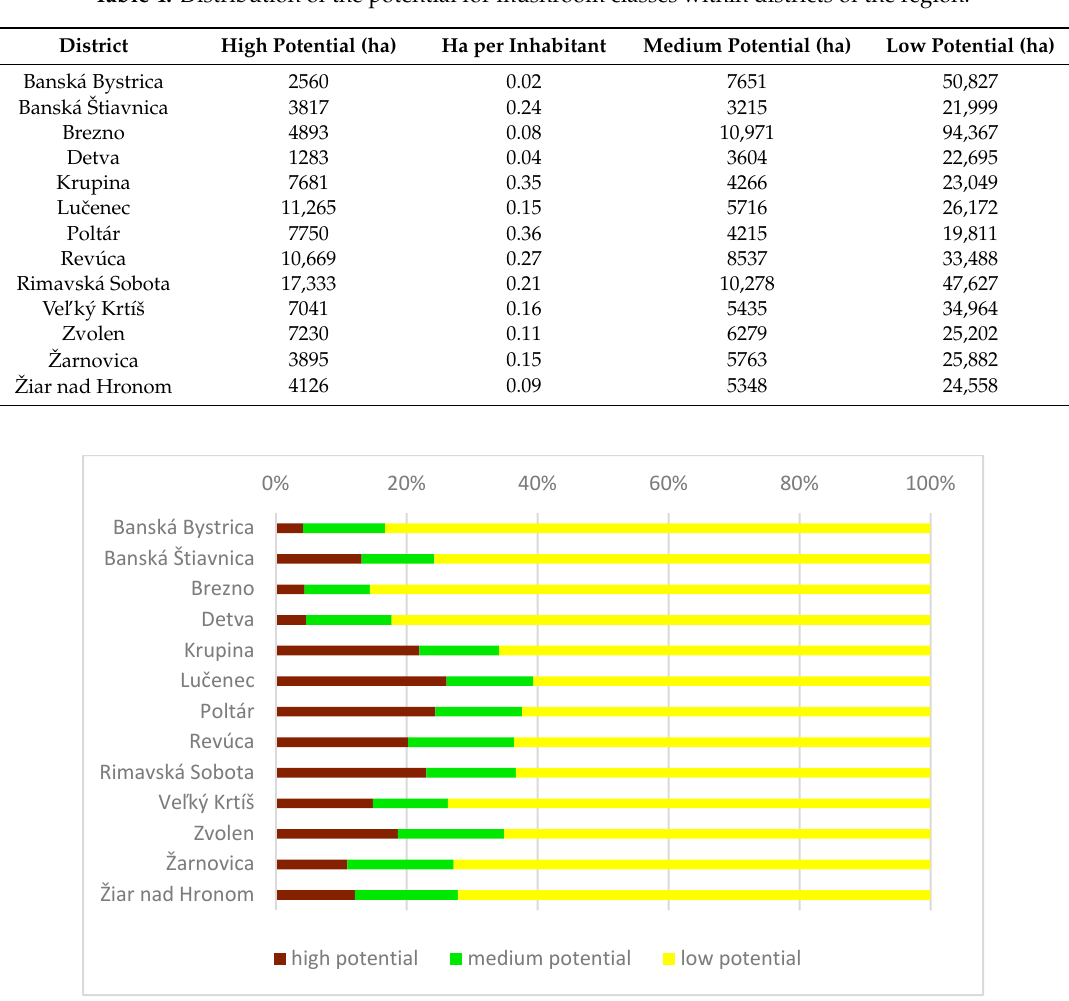
Figure 3. Relative proportions of potential for mushrooms within the districts.